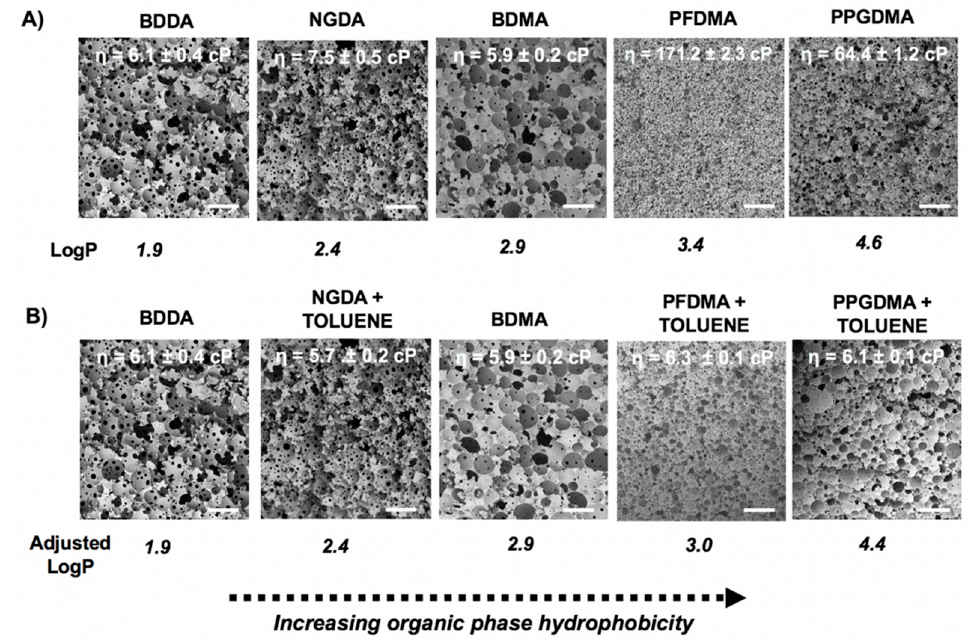
Figure 6. Representative scanning electron micrographs of fracture planes of BDDA, NGDA, BDMA, PFDMA, and PPGDMA polyHIPEs before ( A ) and after normalization of viscosity using toluene as diluent ( B ). LogP and adjusted logP values are reported below each SEM. Average organic phase viscosities are reported on each image. Scale bar is 100 µm.